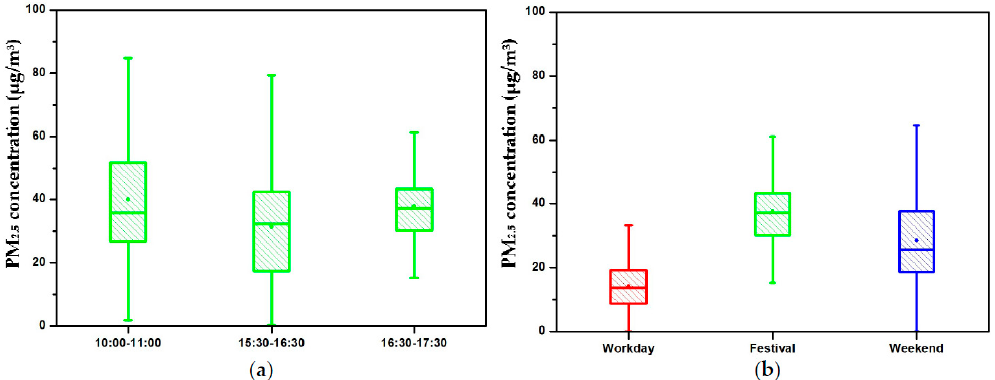
Figure 5. Box plots of PM 2.5 concentration in the passageway. ( a ) During different time period in a day; ( b ) During different